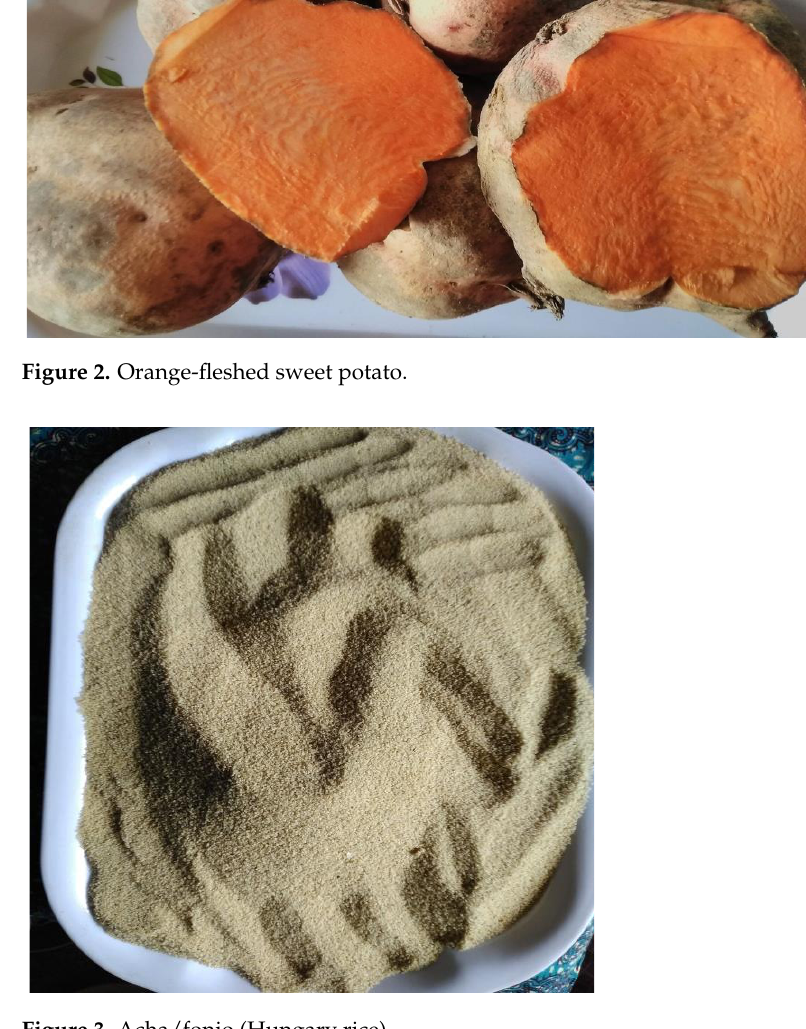
Figure 4. Soybean seed. 2.4. Proximate Composition Moisture content, crude fiber, ash, protein and fat were determined using the AOAC [20] method, and carbohydrate content was determined by difference. 2.5. Determination of Iron Using Atomic Absorption Spectrophotometer (AAS) 2.5.1. Sample Preparation Iron was determined using AAS as described by AOAC [20]. One gram (1 g) of the sample was first digested with 30 mL of aqua regia, which is a mixture of concentrated HNO 3 and HCL, in a ratio of 1:3. The digested sample was filtered and increased up to 50 mL with deionized water. The aliquots of the digested filtrate were used for AAS using filters that match the different elements. 2.5.2. Determination of Zinc Zinc content of the sample was determined according to AOAC [20]. An amount of 5 mL of the filtrate was pipetted into duplicate tubes, to which 4.6 mL of actetateacetic acid buffer solution was added, followed by gentle shaking for 10 min. Dithizone (0.4 mL)